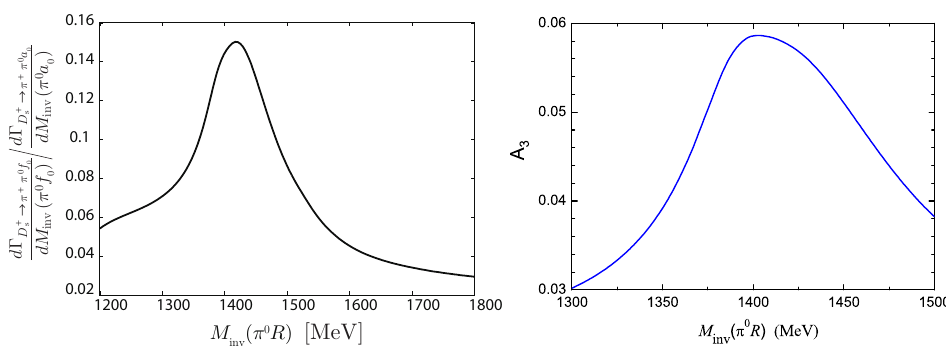
Figure 6. Ratio of d Γ / d M inv ( π 0 f 0 ) and d Γ / d M inv ( π 0 a 0 ) as a function of M inv ( π 0 R ) ( R = f 0 , a 0 ), for → π + π 0 R (left) and ¯ B 0 D + s